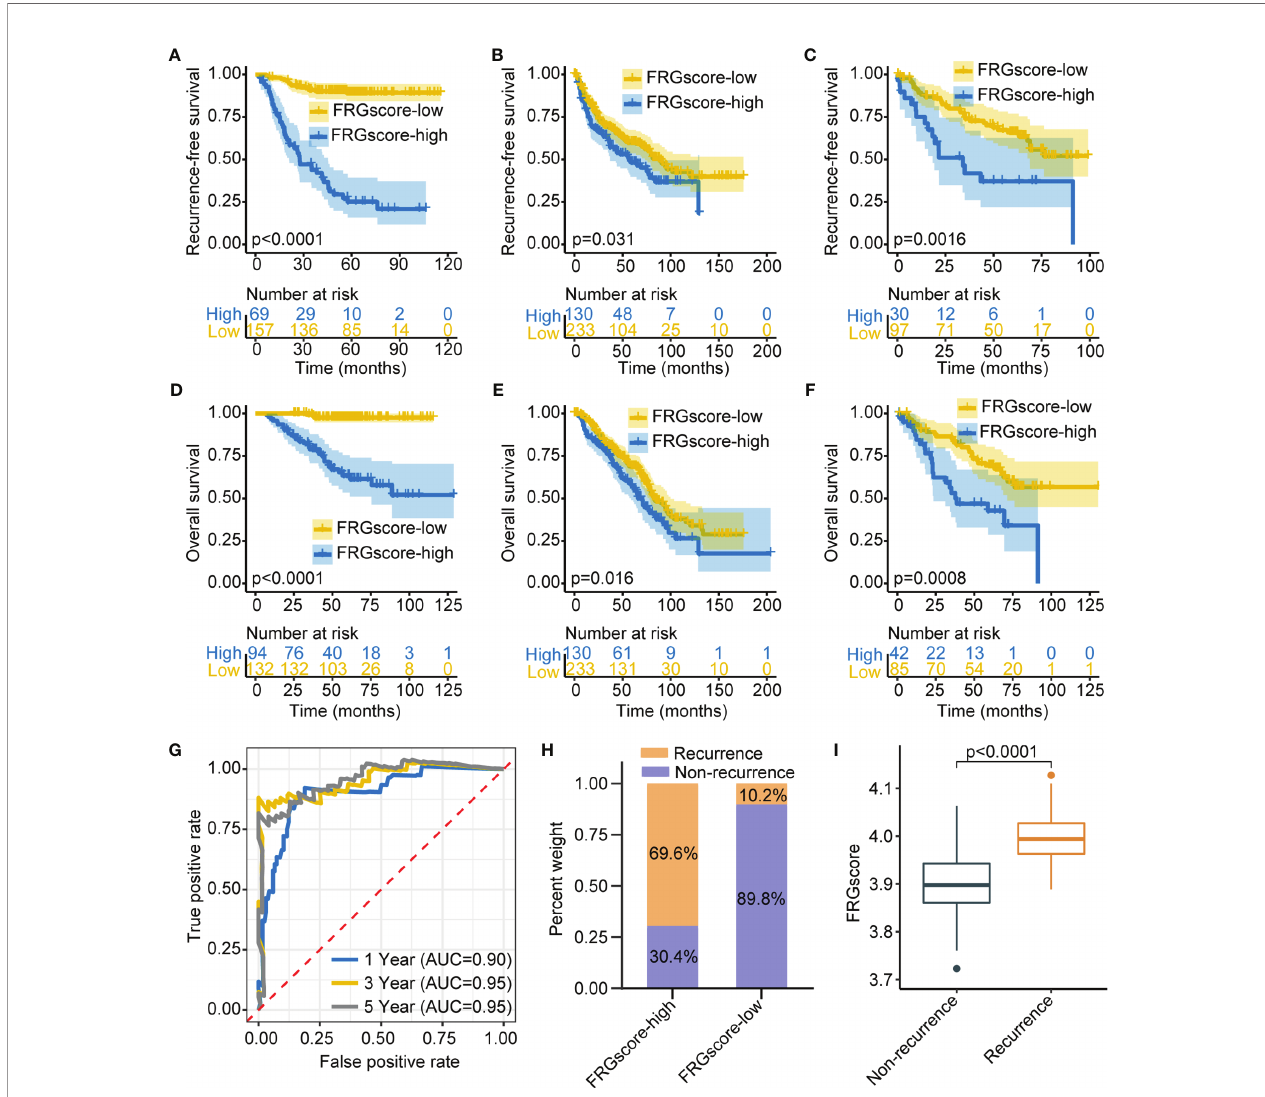
FIGURE 3 | Validation of FRGscore in three independent cohorts. (A – C) Kaplan – Meier curves of recurrence-free survival between FRGscore-high versus FRGscore- low subgroups in GSE31210 cohort (A) , GSE68465 cohort (B) , and GSE50081 cohort (C) . (D – F) Kaplan – Meier curves of OS between FRGscore-high versus FRGscore-low subgroups in GSE31210 cohort (D) , GSE68465 cohort (E) , and GSE50081 cohort (F) . (G) Time-dependent ROC analysis based on FRGscore for predicting recurrence risk at 1, 3, and 5 years in GSE31210 cohort. (H) Proportion of recurrence risk in FRGscore-high or FRGscore-low subgroups in GSE31210 cohort. (I) Difference in FRGscore between recurrence and non-recurrence subgroups in GSE31210 cohort. FRGscore, ferroptosis-related gene score; OS, overall survival; ROC, receiver operating